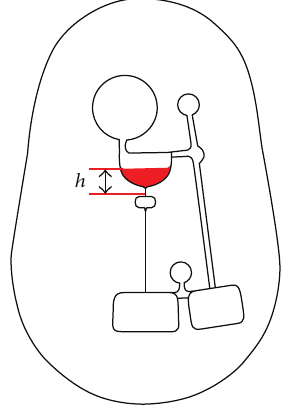
Figure 9: The definition of liquid